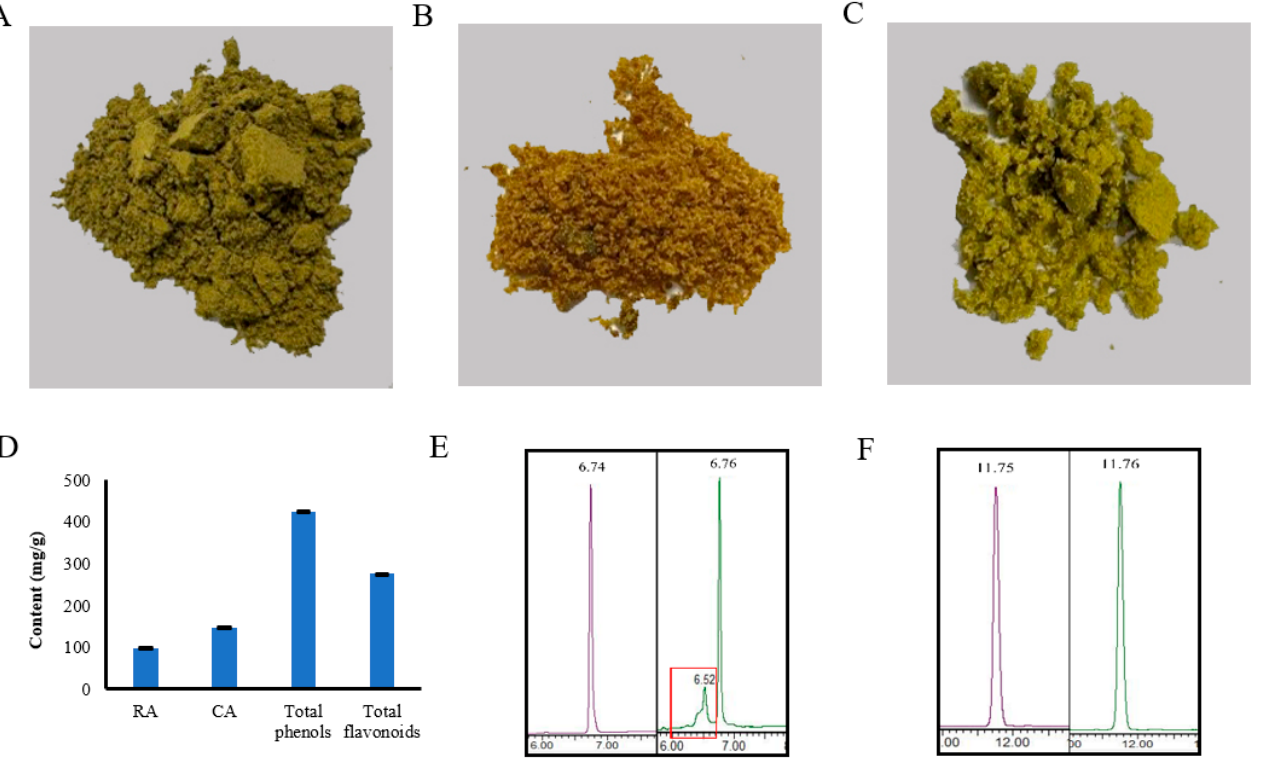
Figure 2. Analysis of the RCE ( A ), RA ( B ), and CA ( C ) powder. ( D ), RCE composition analysis. ( E ), Purple: HPLC data for RA standard; green: HPLC data for RA obtained by the preparative liquid chromatograph from the RCE; red square: HPLC data for impurities in RA. ( F ), Purple: HPLC data for CA standard; green: HPLC data for CA obtained by the preparative liquid chromatograph from the RCE.